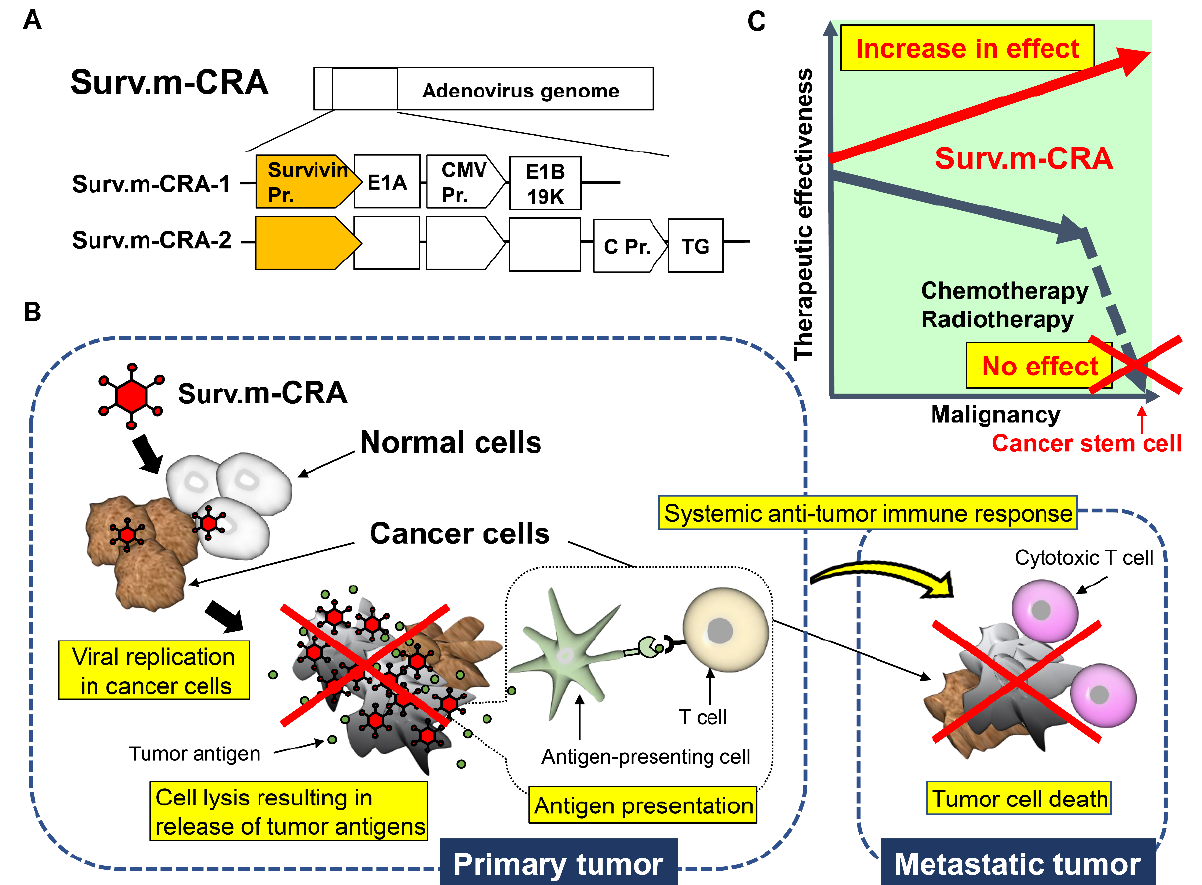
Figure 3. Therapeutic mechanism and characteristic features of survivin-responsive m-CRA (Surv.m-CRA). ( A ) The basic constitution of Surv.m-CRA. ( B ) Therapeutic mechanism of OV therapy, including Surv.m-CRA. ( C ) The putative therapeutic advantage of Surv.m-CRA against cancer stem cells in comparison to conventional chemo-radiotherapy.